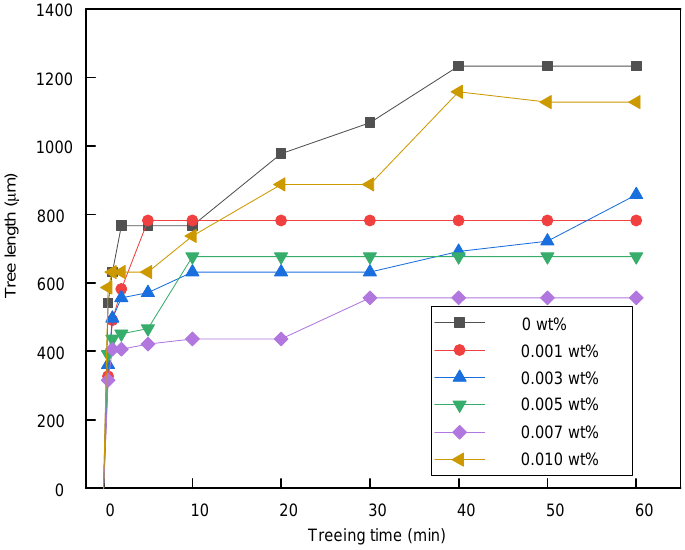
ff erent graphene